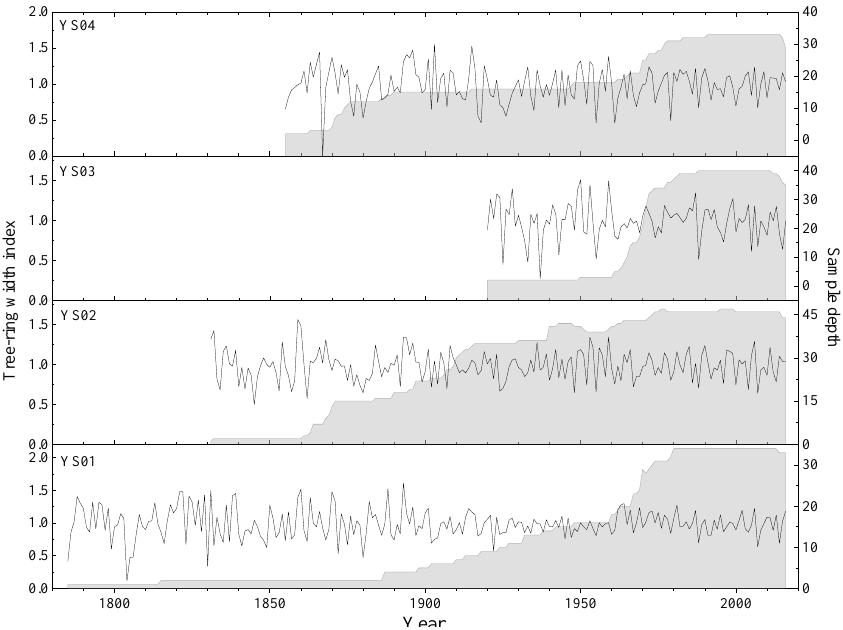
Figure 2. Residual chronologies and the sample depths of the four groups of samples at Mt. Yao, central China. Table 1. Statistical characteristics of the chronologies from the four sampling sites at Mt. Yao, central China.